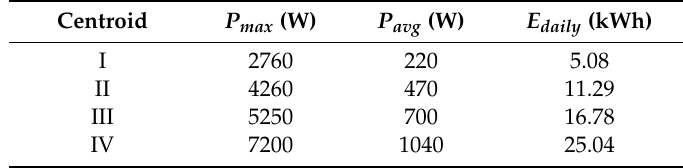
Table 2. Characteristics of the load profiles corresponding to the centroids.